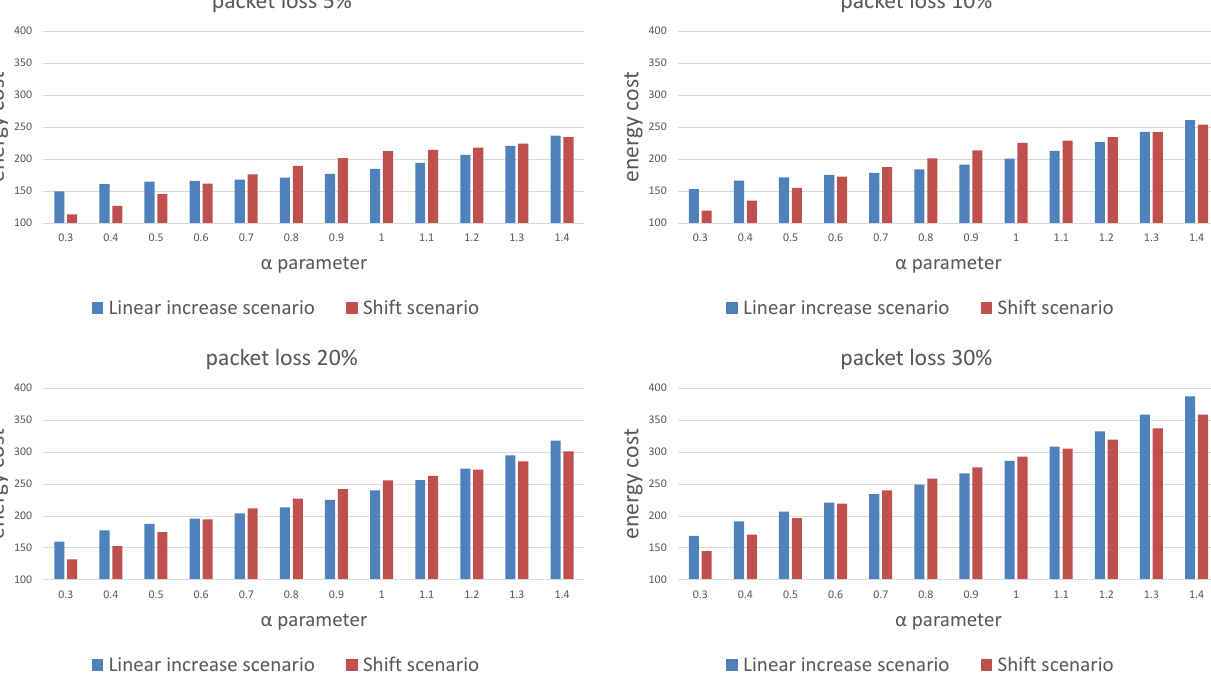
Figure 8. Comparison of the energy cost for different packet loss probability for the linear window size increase and window shift